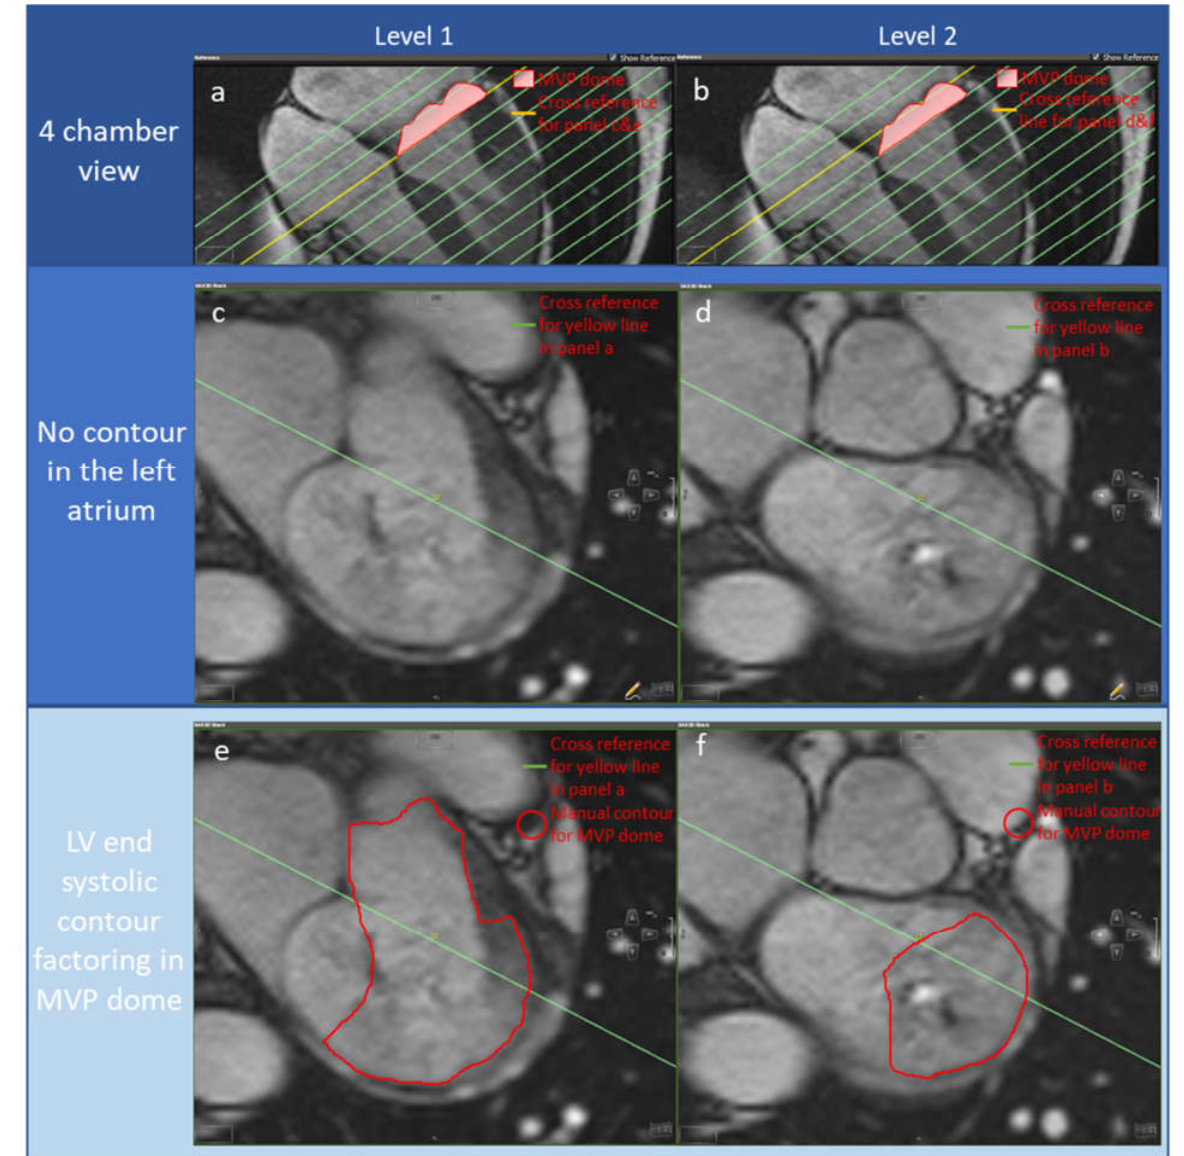
Figure 1. A case example of a mitral valve prolapse patient wherein AI failed to factor in the prolapse, resulting in a 34 mL difference at the systole phase. Panel ( a , b ): yellow reference lines for images in panels ( c , e ), and ( d , f ), respectively. Panel ( c , d ): SAX slides at the end-systole phase without including the MVP doming volume. Panel ( e , f ): SAX slides at the systole phase in which manual refinements (red contour) are applied to include the MVP doming volume in LVESV.